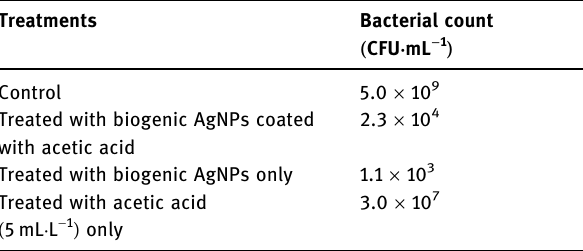
Table 5: E ff ects of Ag - NPs and biogenic Ag NPs coated with acetic acid in broiler chickens on intestinal microbiota total count in the